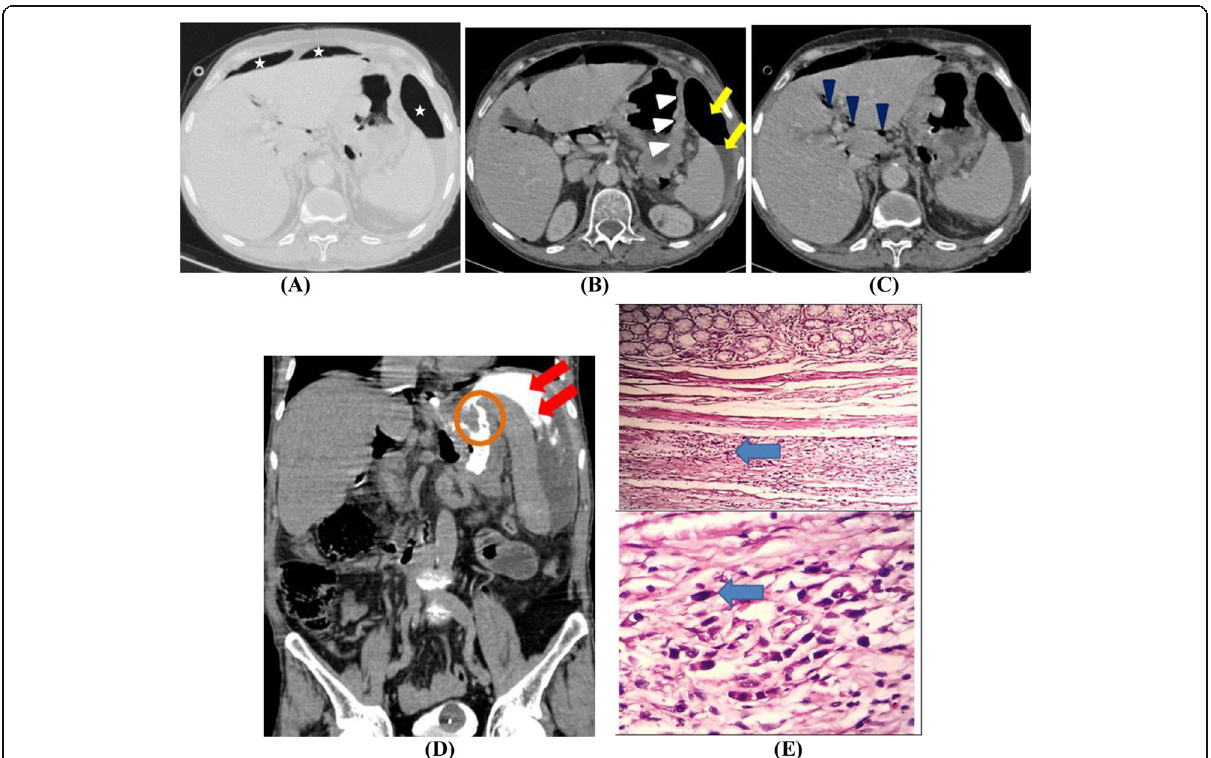
Fig. 2 Perforated gastric carcinoma in a 73-year-old male patient presented with acute epigastric pain. a Non-contrast CT axial (lung window) image, showing a supramesocolic pneumoperitoneum (stars). b Post IV contrast CT axial image shows diffuse enhancing irregular thickening of gastric wall more evident at the fundal region (white arrowheads) and hydro-pneumoperitoneum (yellow arrows). c Post IV contrast CT axial image showing free air in ligamentum teres (blue arrowheads). d CT coronal post IV and oral contrast CT image, showing active contrast leakage on delayed phase (red arrows) through a focal defect in posterior gastric fundal wall (circle). e Histopathology showing infiltration of the deep muscle layer by sheets of highly pleomorphic tumor cells, confirming radiological findings of gastric carcinoma